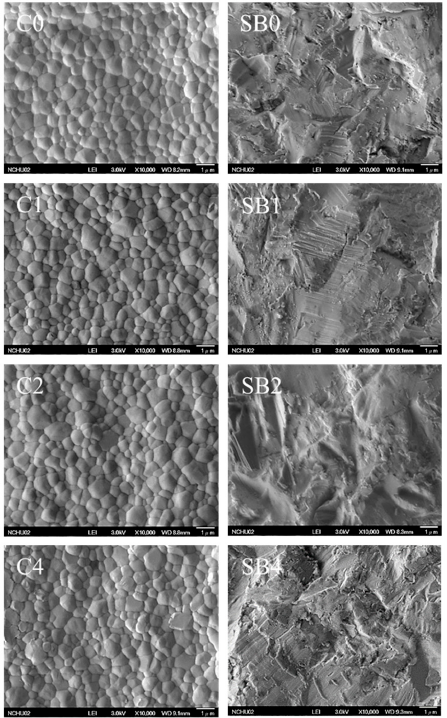
Figure 1. SEM images of the two zirconia surfaces before and after treatment with different plasma powers.